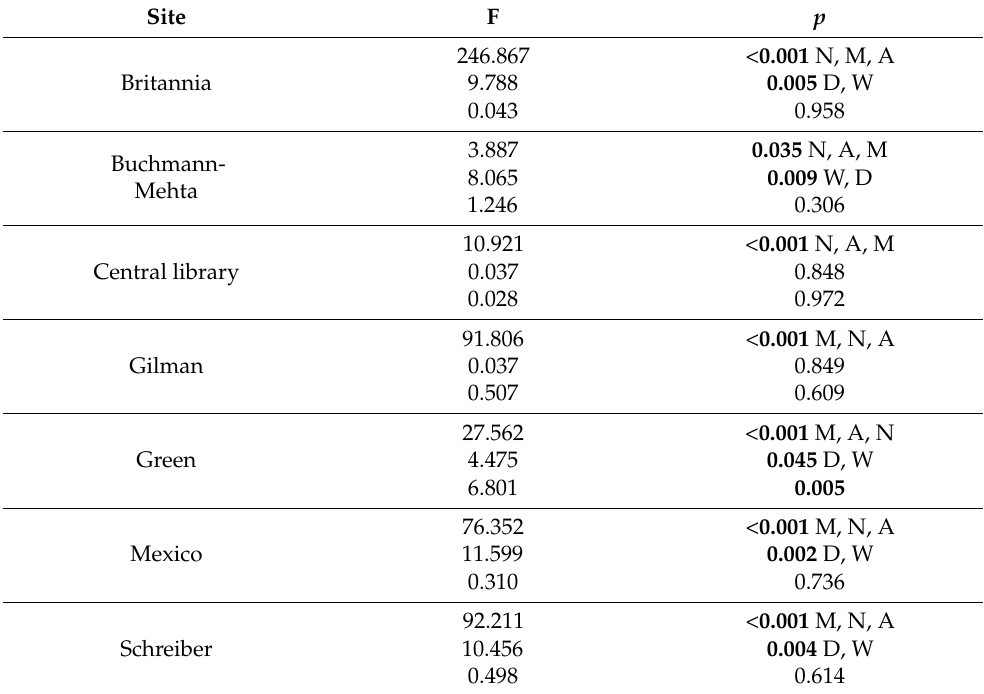
Table 2. Statistics for the change in illumination with daytime in early March (M = Morning, N = Noon, A = Afternoon) and the difference between positions next to the walls and distant from the walls (W, D). At each site, the three rows stand for each explanatory variable tested: time (df = 2, 24), position (1, 24), and their interaction (2, 24). The order of letters indicates how daytimes and positions differ (larger values first). Significant results appear in bold. Site F p Britannia